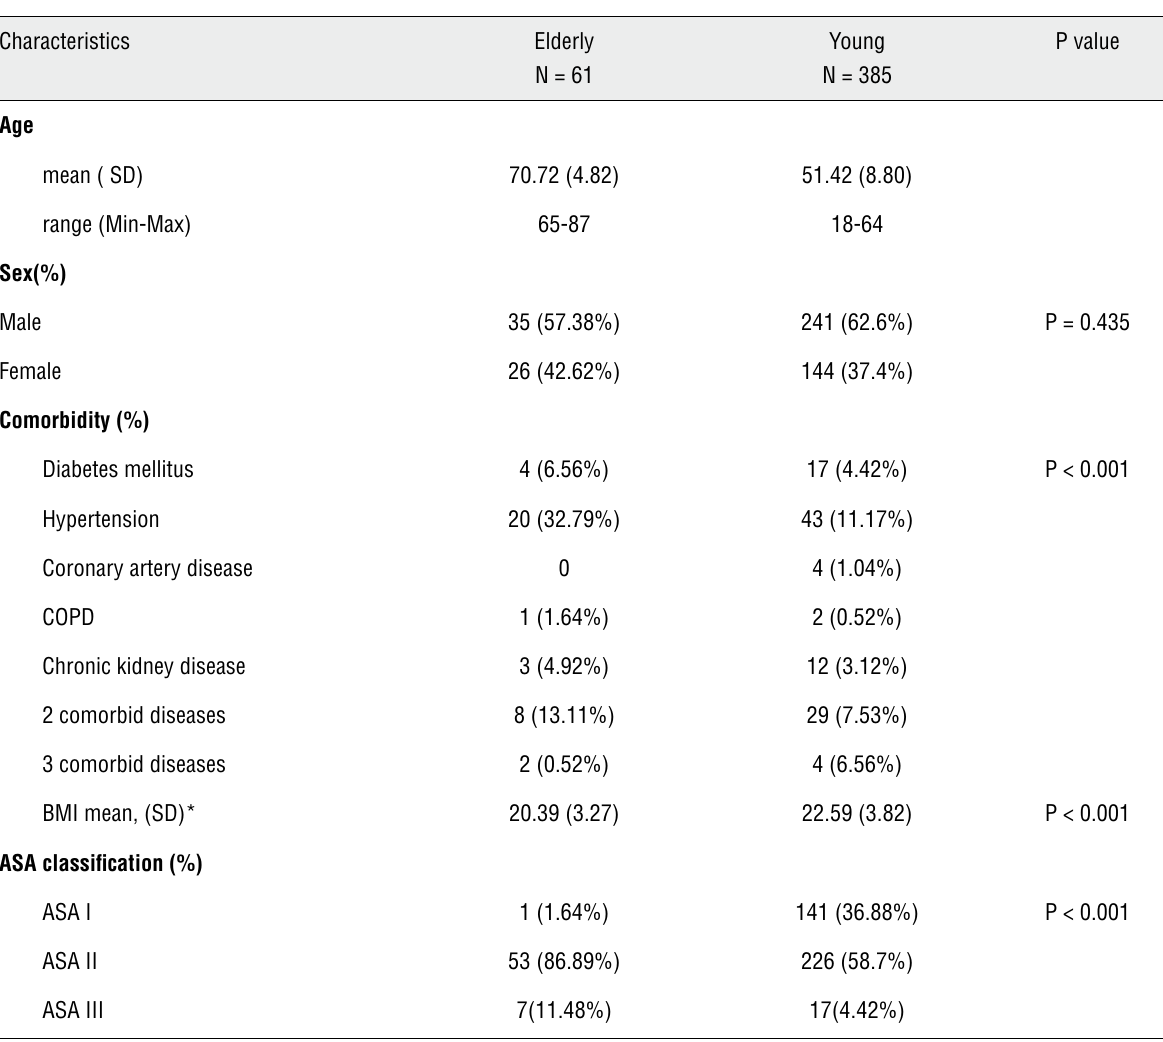
Table 1- Patient’s